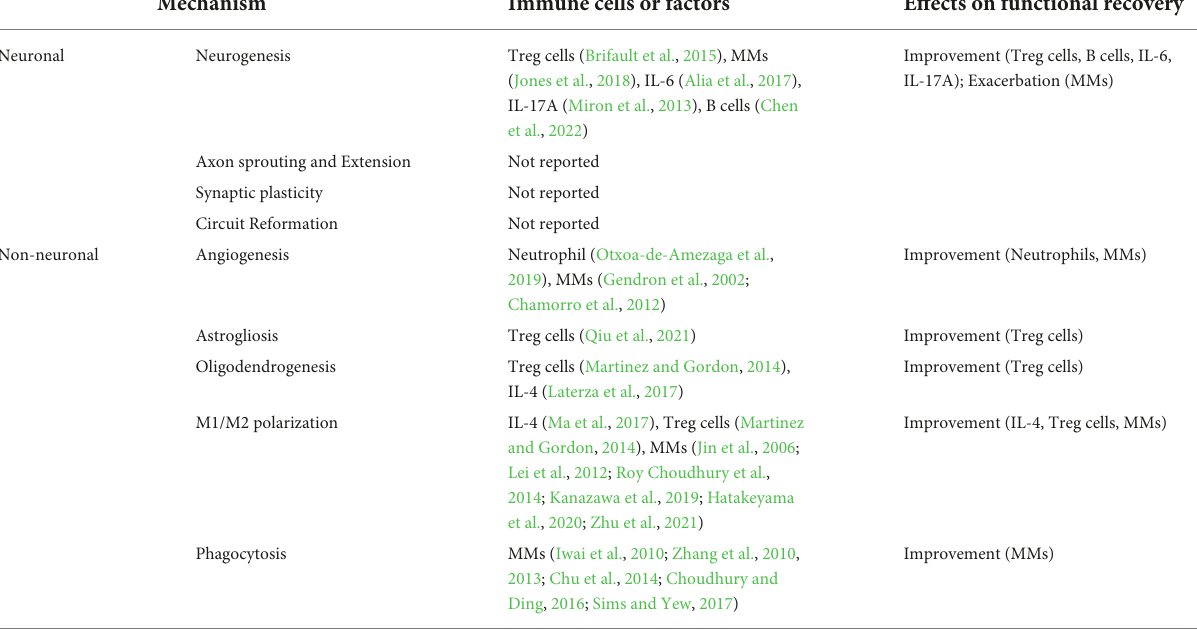
TABLE 1 Mechanisms of peripheral immune system in functional recovery after ischemic